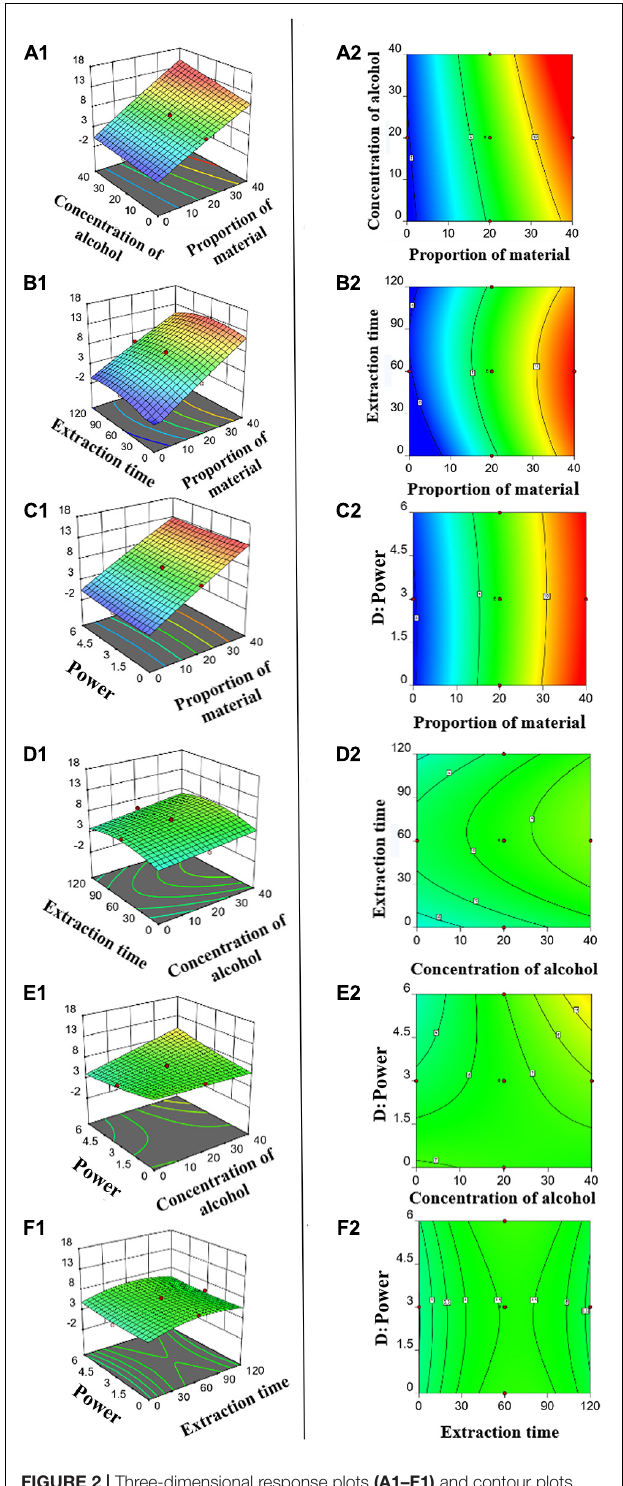
FIGURE 2 | Three-dimensional response plots (A1–F1) and contour plots (A2–F2) for optimized process parameters . (A1,A2) Proportion of material versus concentration of alcohol. (B1,B2) Proportion of material versus time. (C1,C2) Proportion of material versus power. (D1,D2) Concentration of alcohol versus time. (E1,E2) concentration of alcohol versus power. (F1,F2) time versus